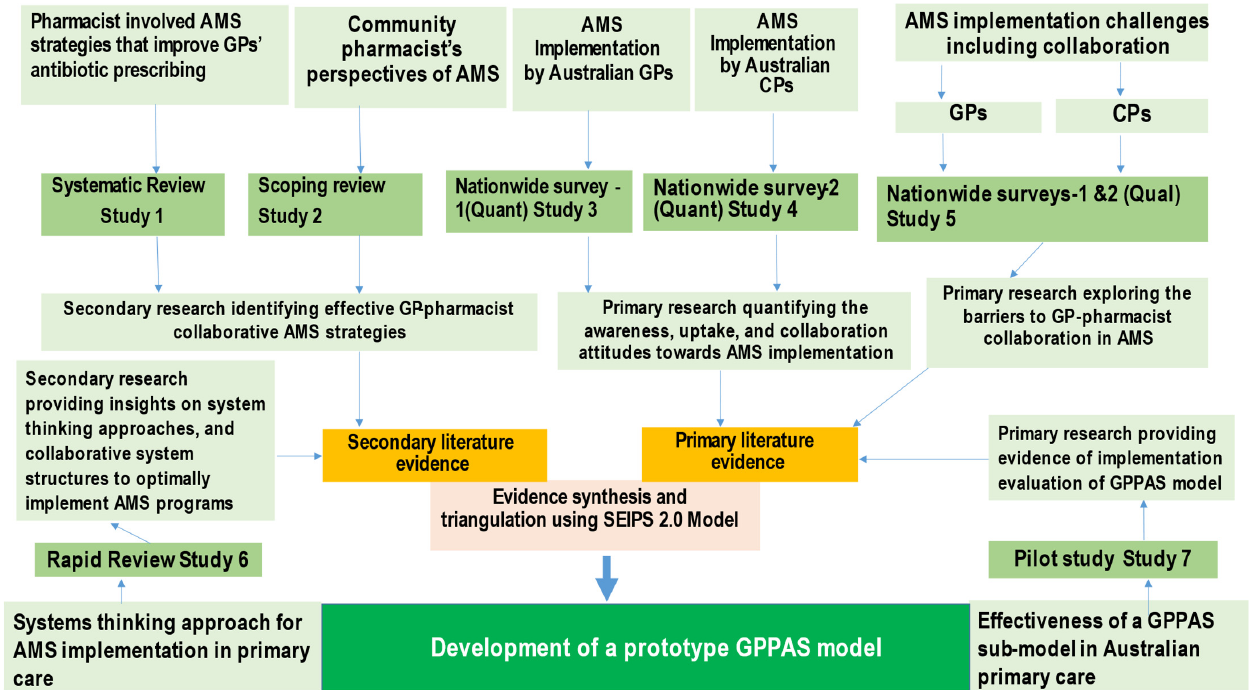
Figure 2. Stepwise development of the GPPAS model. Secondary research indicates reviews collecting secondary data from published studies. Primary research indicates studies that collected primary data in the context of Australian primary care.